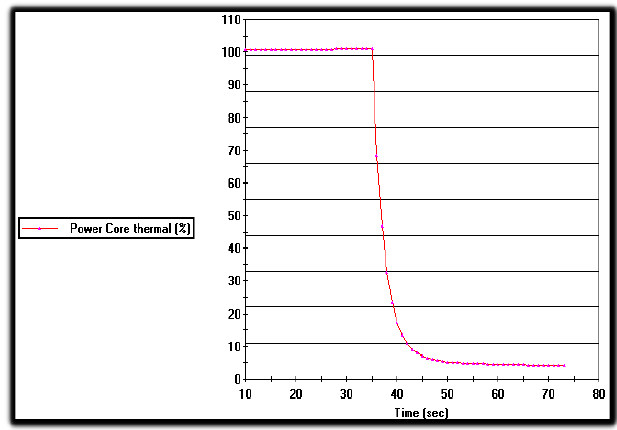
Fig. 18. Transient reactor thermal power under inadvertent opening of pressurizer safety valves